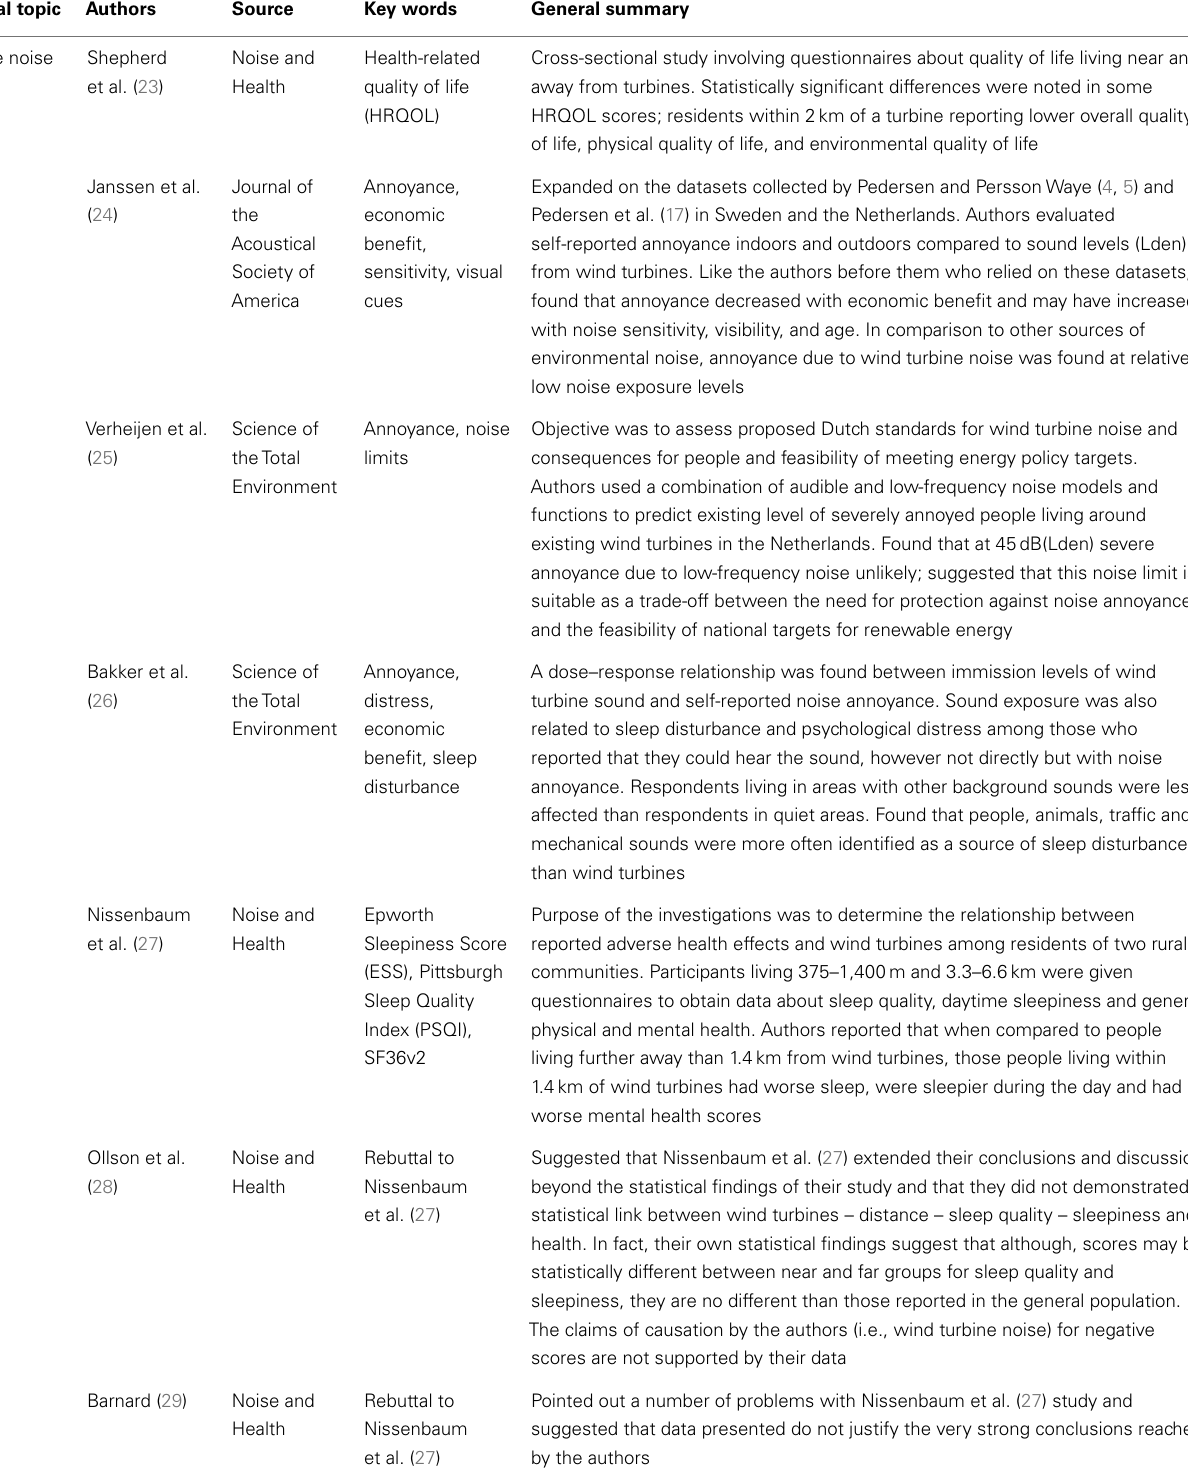
Table 1 | General summary of reviewed articles